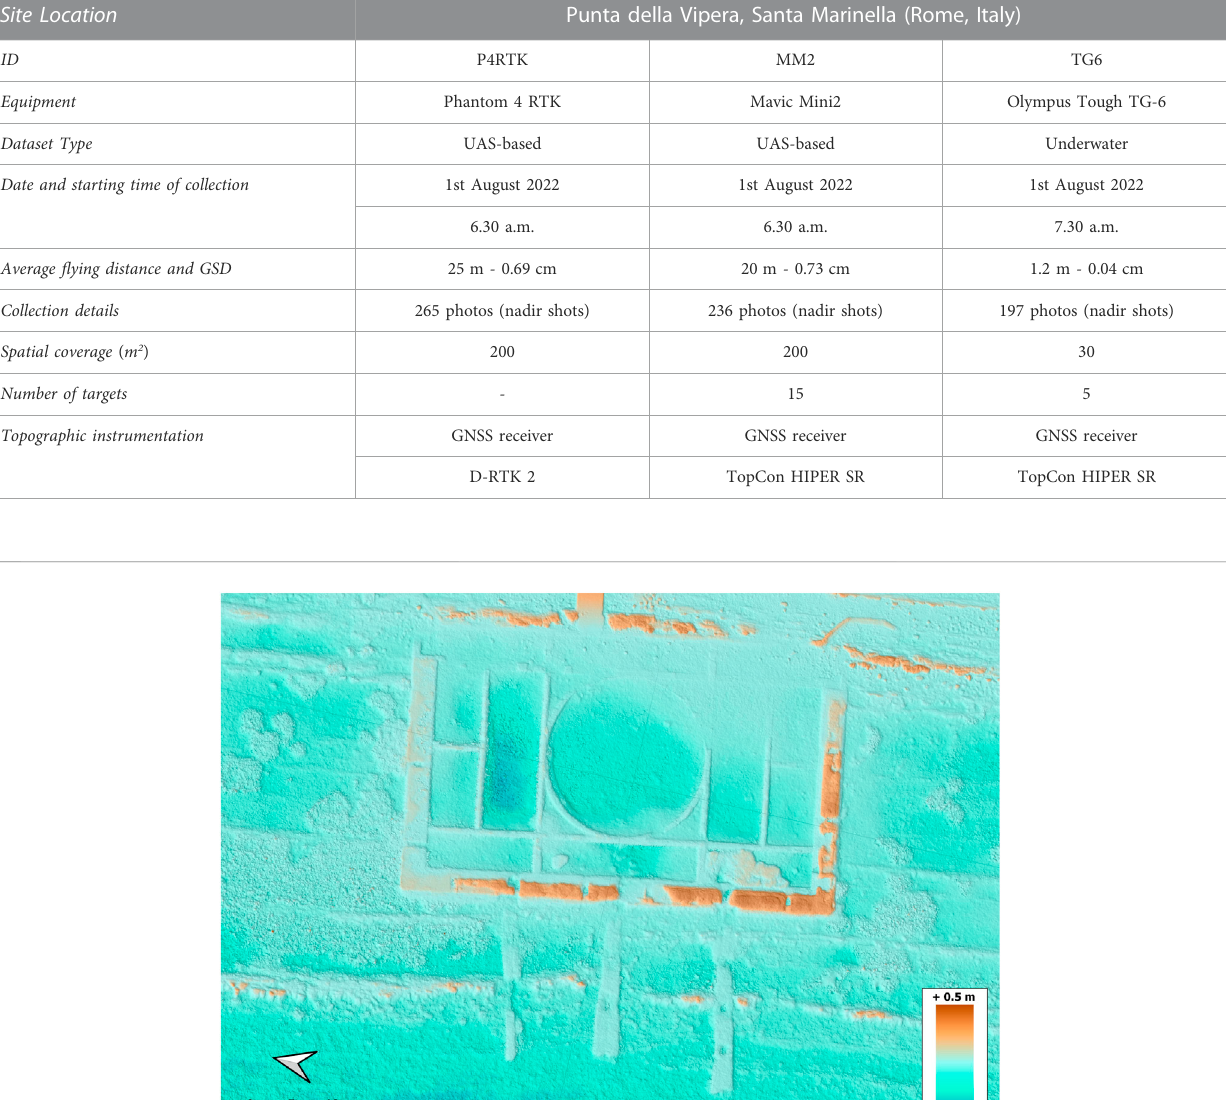
TABLE 6 Data collection information.